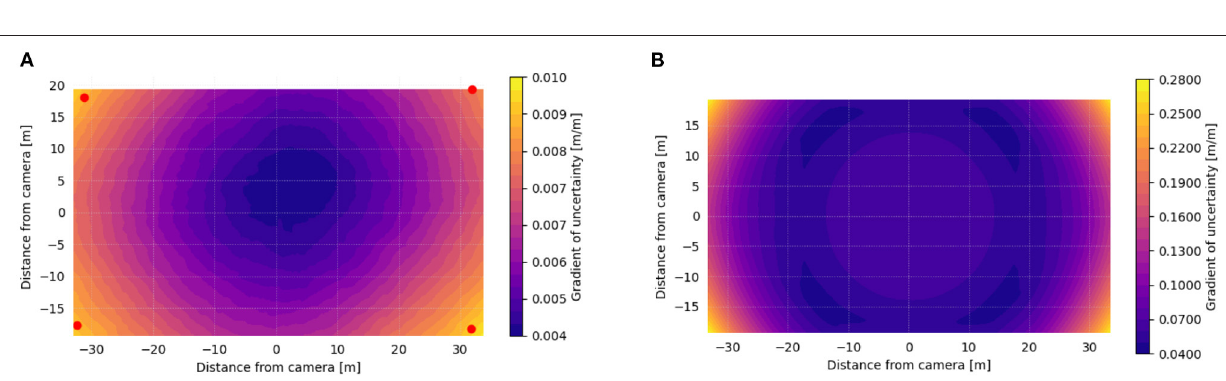
on the order of 5 times greater than the GCP-based